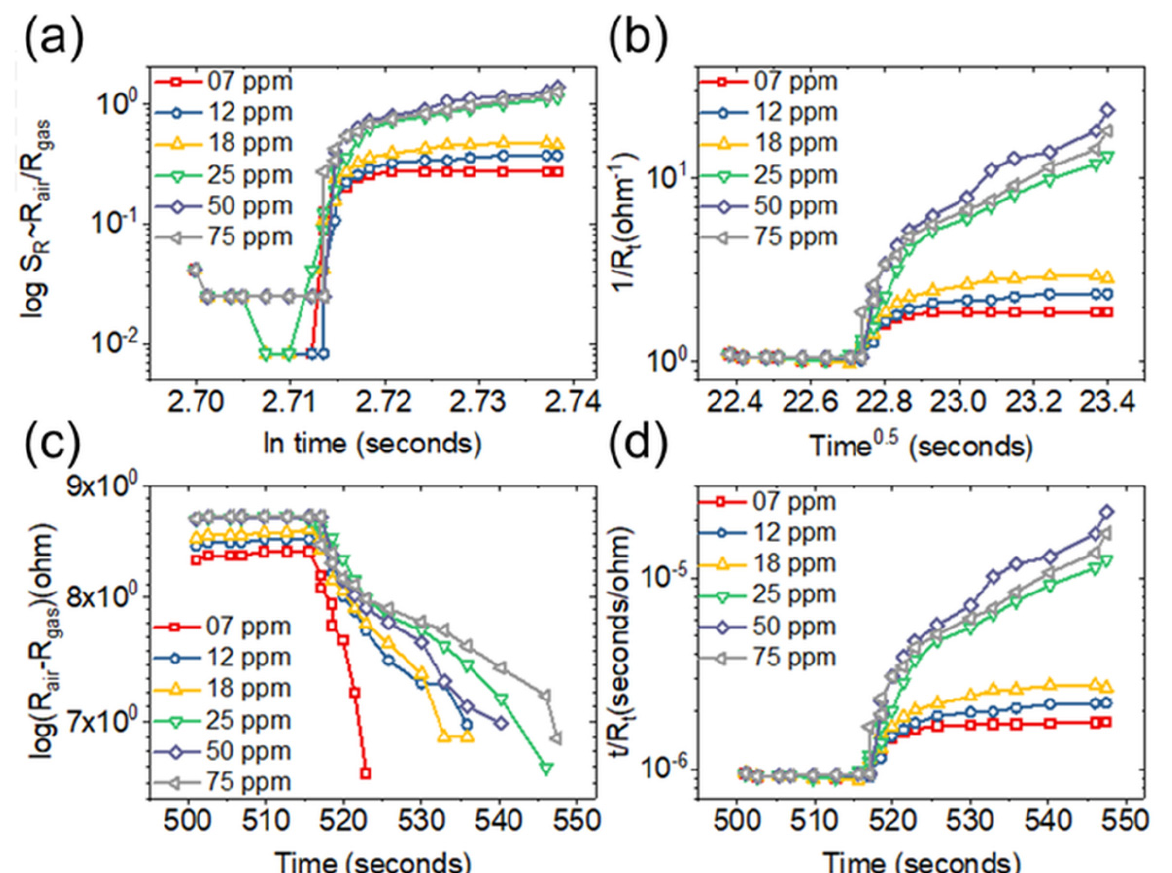
Figure 8. The response and regression analysis of NO 2 adsorption (7, 12, 18, 25, 50, and 75 ppm) on the Pt/Cr-TiO 2 /Pt surface. The original data are shown as color symbols, and their fitting is shown with various color dashed lines. The data were fitted by using the Elovich model ( a ), inter-particle diffusion model ( b ), pseudo first-order model also known as Lagergren’s first-order model ( c ) and pseudo second-order model also known as Ho’s second-order model ( d ).